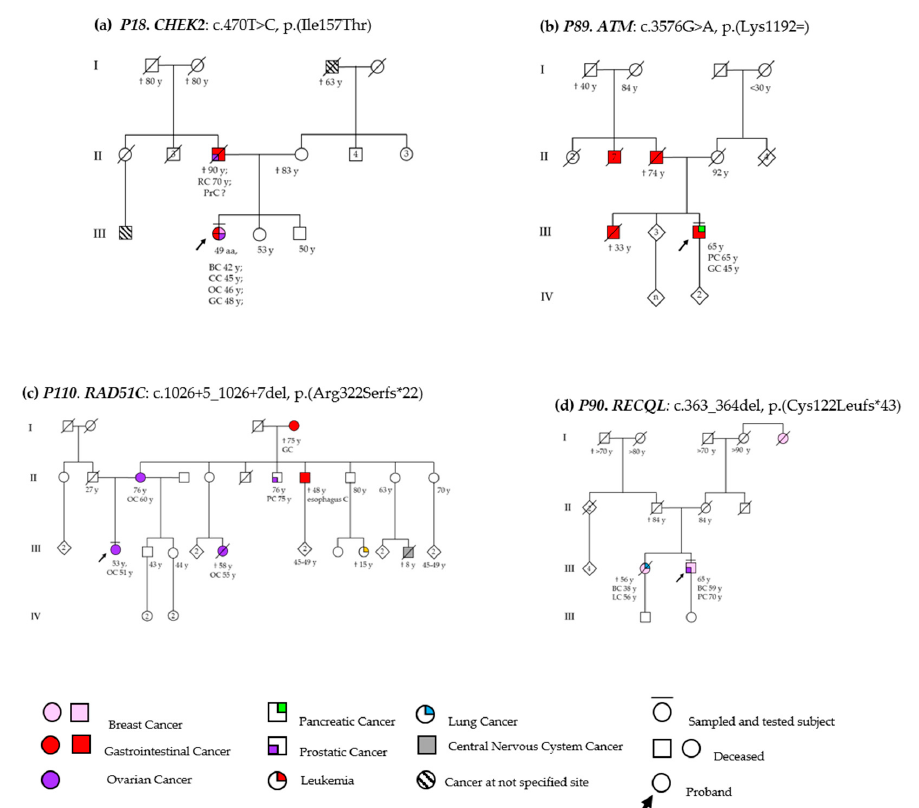
Figure 2. Pedigrees of four families with P/LP variants. Individuals with any cancer are shown as ( a ) CHEK2 family, ( b ) ATM family, ( c ) RAD51C family, ( d ) RECQL family. The tested subject is indicated with a horizontal line above the circle or square. BC, breast cancer; OC, ovarian cancer; GC, gastric cancer; PC, pancreatic cancer; CC, colon cancer; RC, colonrectal cancer; PrC, prostatic cancer; LC, lung cancer.